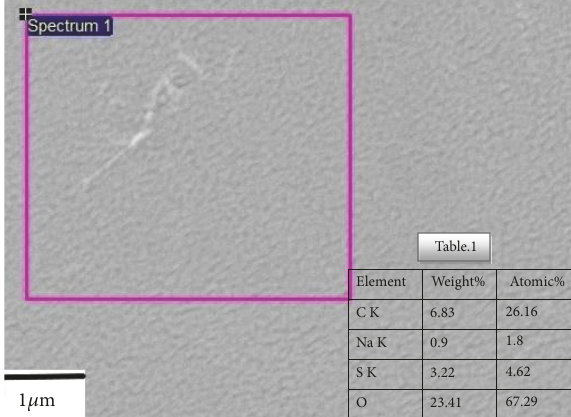
Figure 5: EDAX Analysis of MWCNT-PEDOT:PSS film showing different elements mainly carbon, sodium, sulphur, oxygen as shown